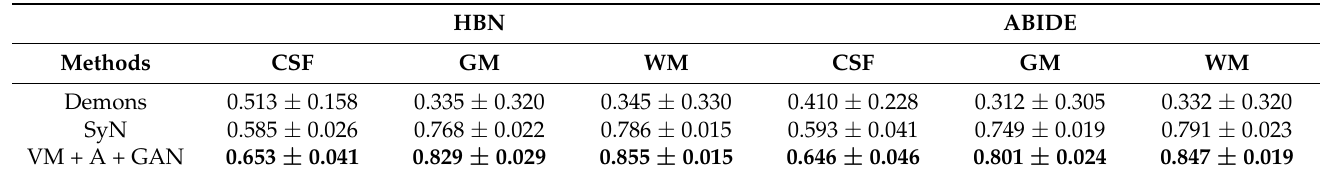
Table 1. Dice values obtained with the HBN and ABIDE datasets. Bold numbers indicate the best results. HBN ABIDE